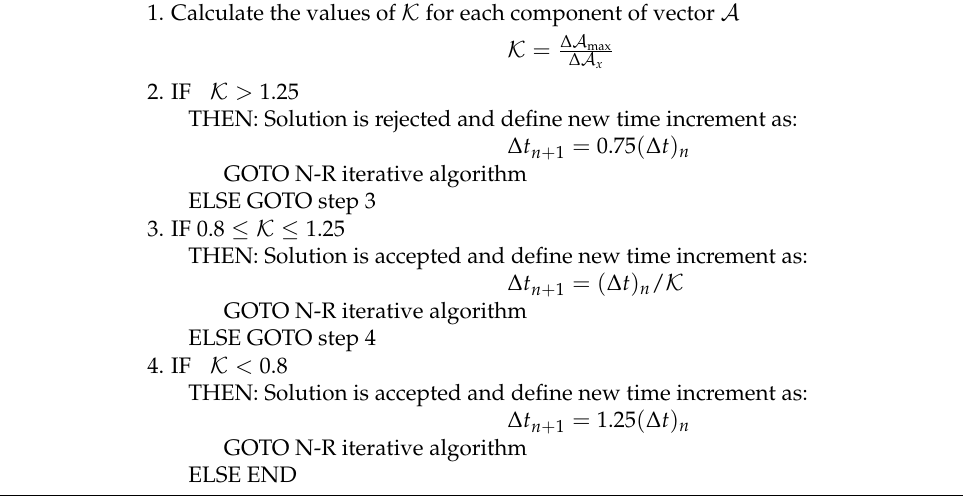
Table 1. Time sub-stepping algorithm for Newton–Raphson Iterative